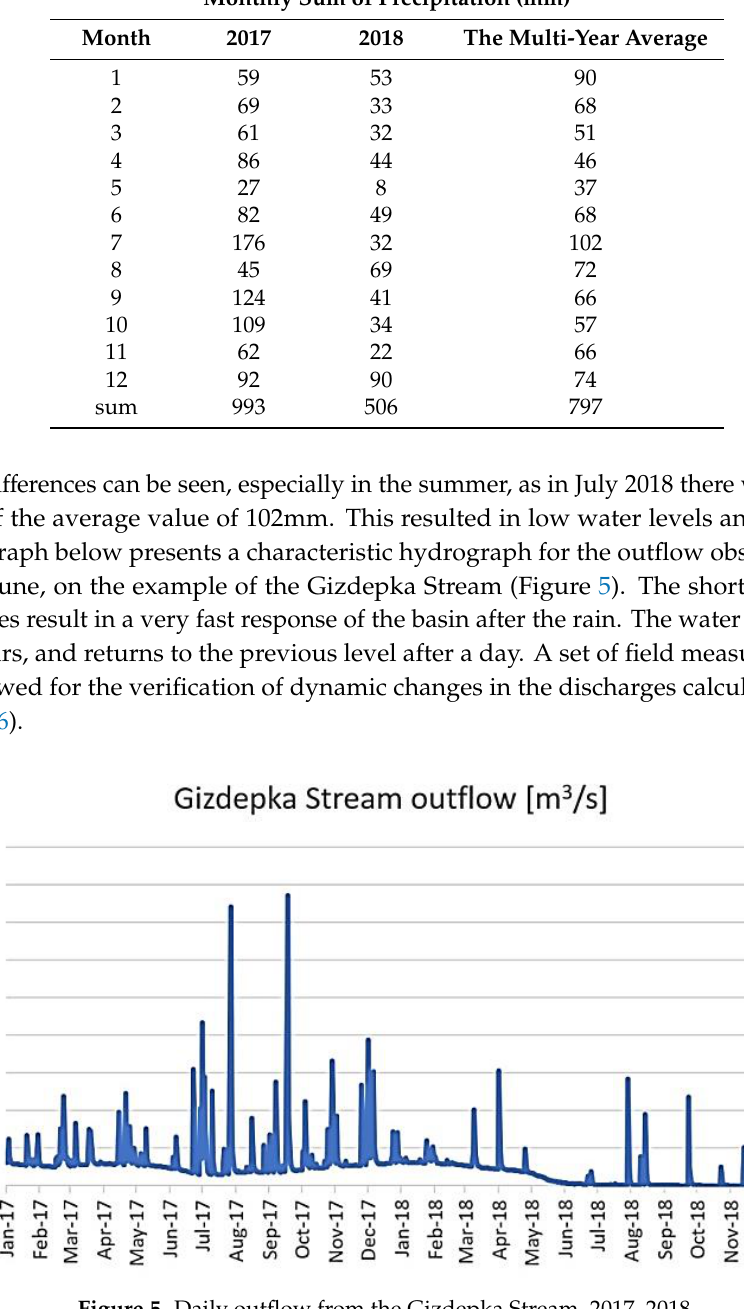
Figure 5. Daily outflow from the Gizdepka Stream, 2017–2018.